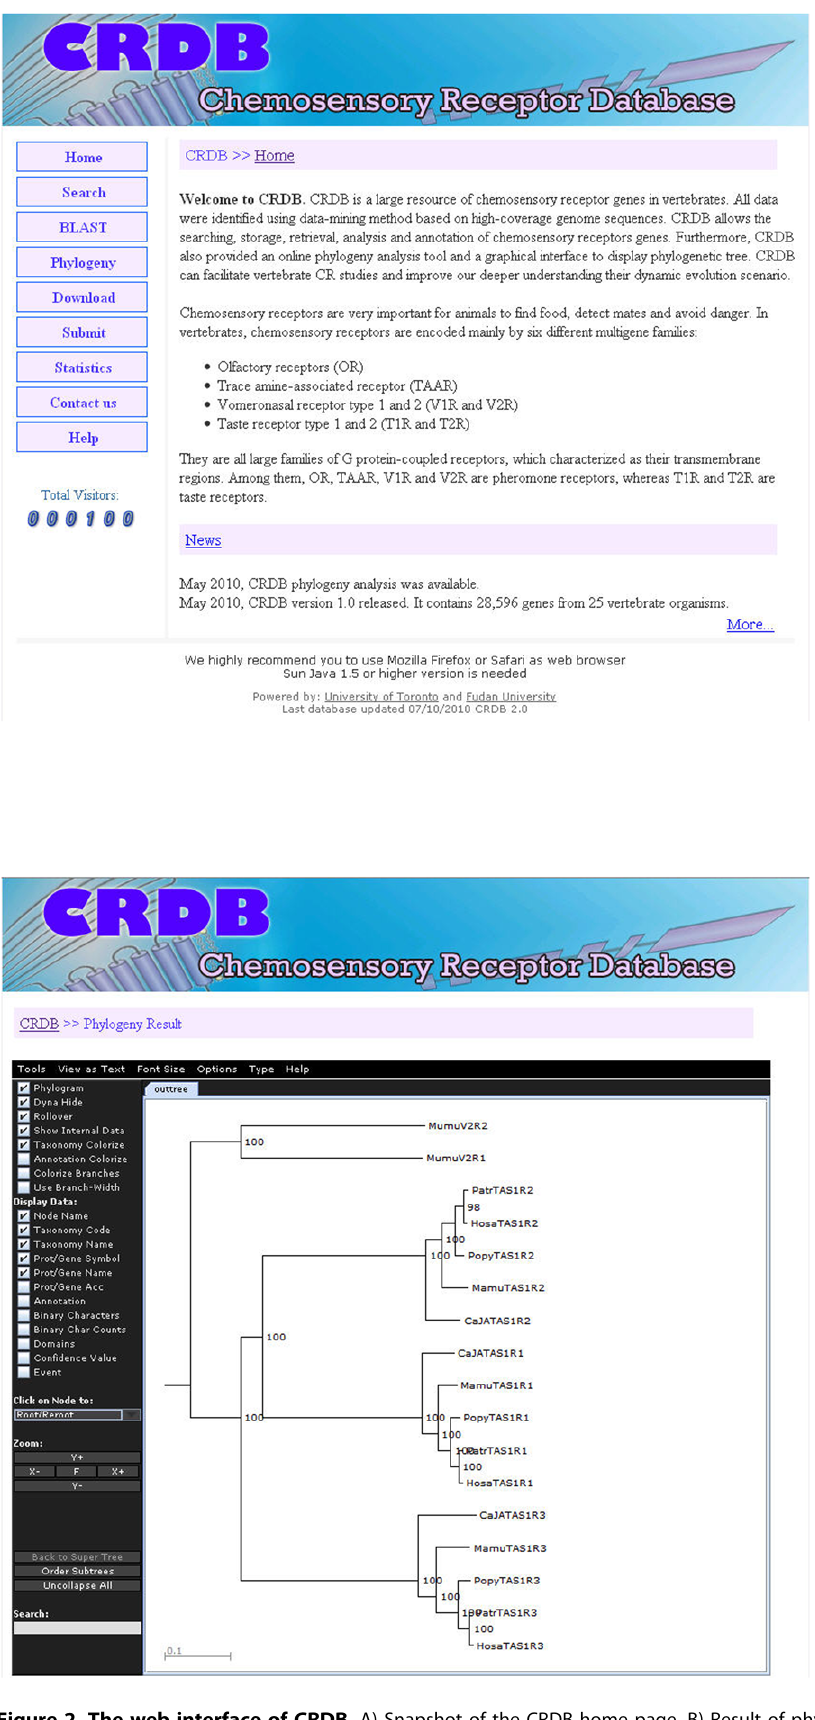
Figure 2. The web interface of CRDB. A) Snapshot of the CRDB home page. B) Result of phylogenetic tree of primate T1R genes. doi:10.1371/journal.pone.0031540.g002 PLoS ONE |